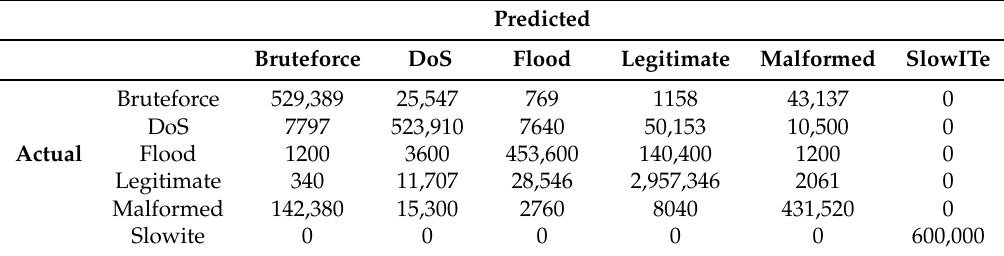
Table 14. Confusion matrix random forest with augmented and balanced traffic.